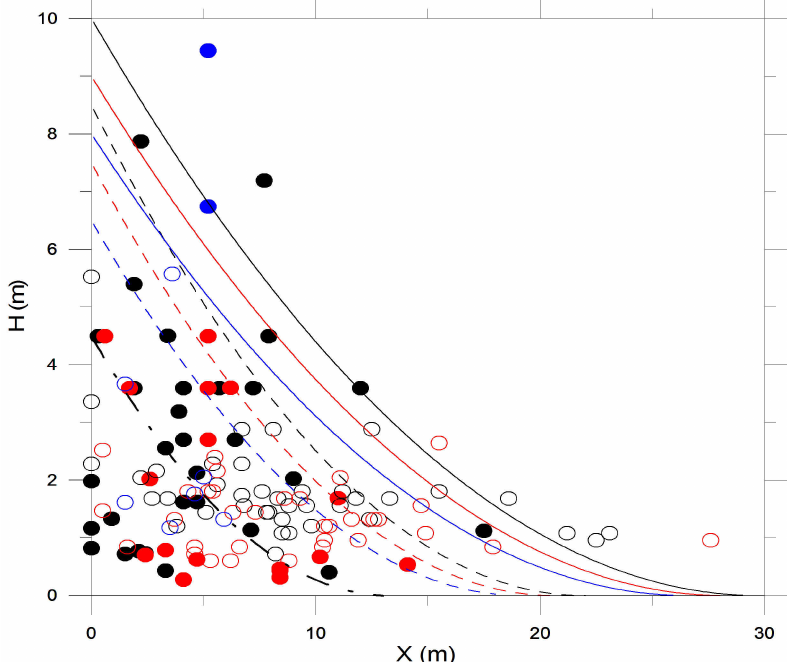
Figure 12. Comparison between the calculated onshore wave height H (lines) and the minimum wave height required to move the boulders H m (circles) as a function of the distance X from the coastline and the coast height H c (colours) for different storm spectral peak waves H 0 . Continuous line: Wave height as a function of the onshore distance calculated by Equation (A6), with T estimated by Equation (1), for the 12–13 November 2019 storm ( H 0 = 9.0 m, H s = 1.5 m). Black: H c = 0.5 m, Red: H c = 1.5 m, and Blue: H c = 2.5 m. Dashed line: same as the continuous line but refers to the October 2018 storm ( H 0 = 7.5 m, H s = 1.5 m). Dot-dashed line: Wave height as a function of the onshore distance calculated by Equation (A6) for H 0 = 4.5 m and H c = 0.5 m. Filled circles: H m calculated by Equations (A1)–(A4) as a function of the initial onshore distance X of the boulder and the coast height (colours as above). Empty circles: H m calculated by Equation (A5) as a function of the final onshore distance X of the boulder and the coast height (colours as